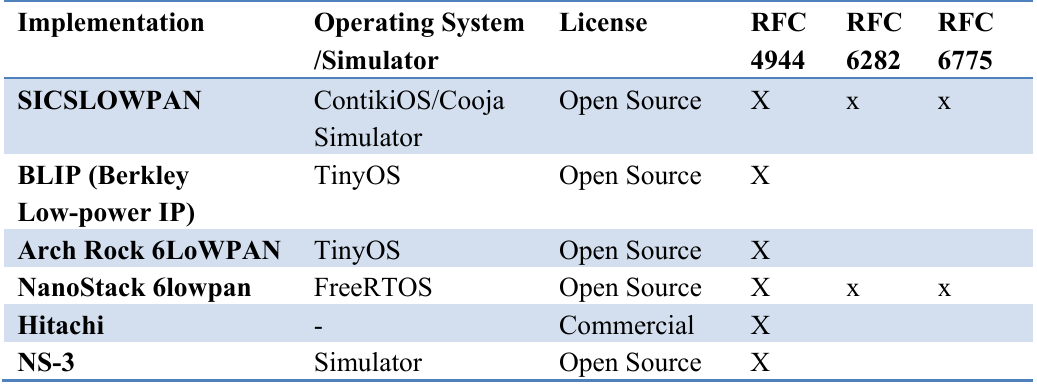
Table 3. 6LoWPAN